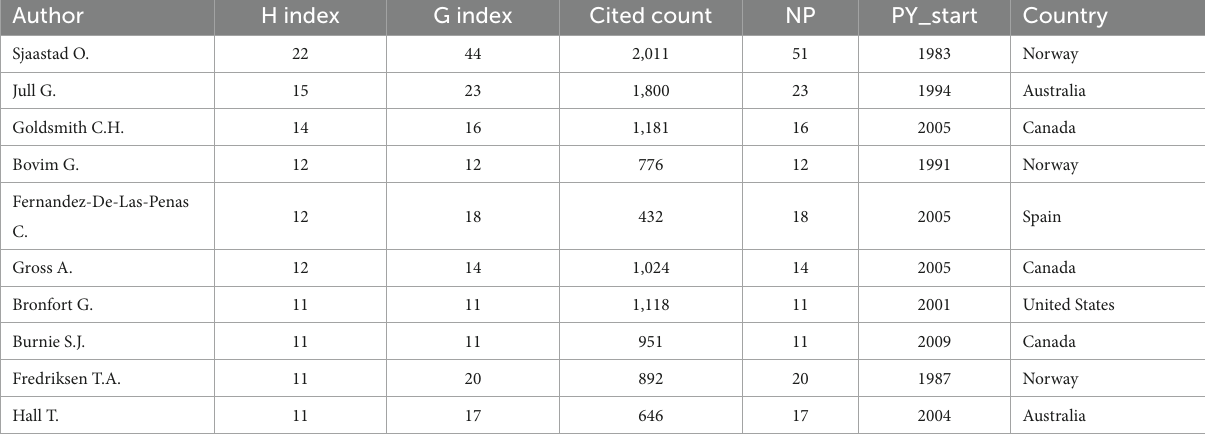
TABLE 4 Top 10 most influential authors based on the H-index.